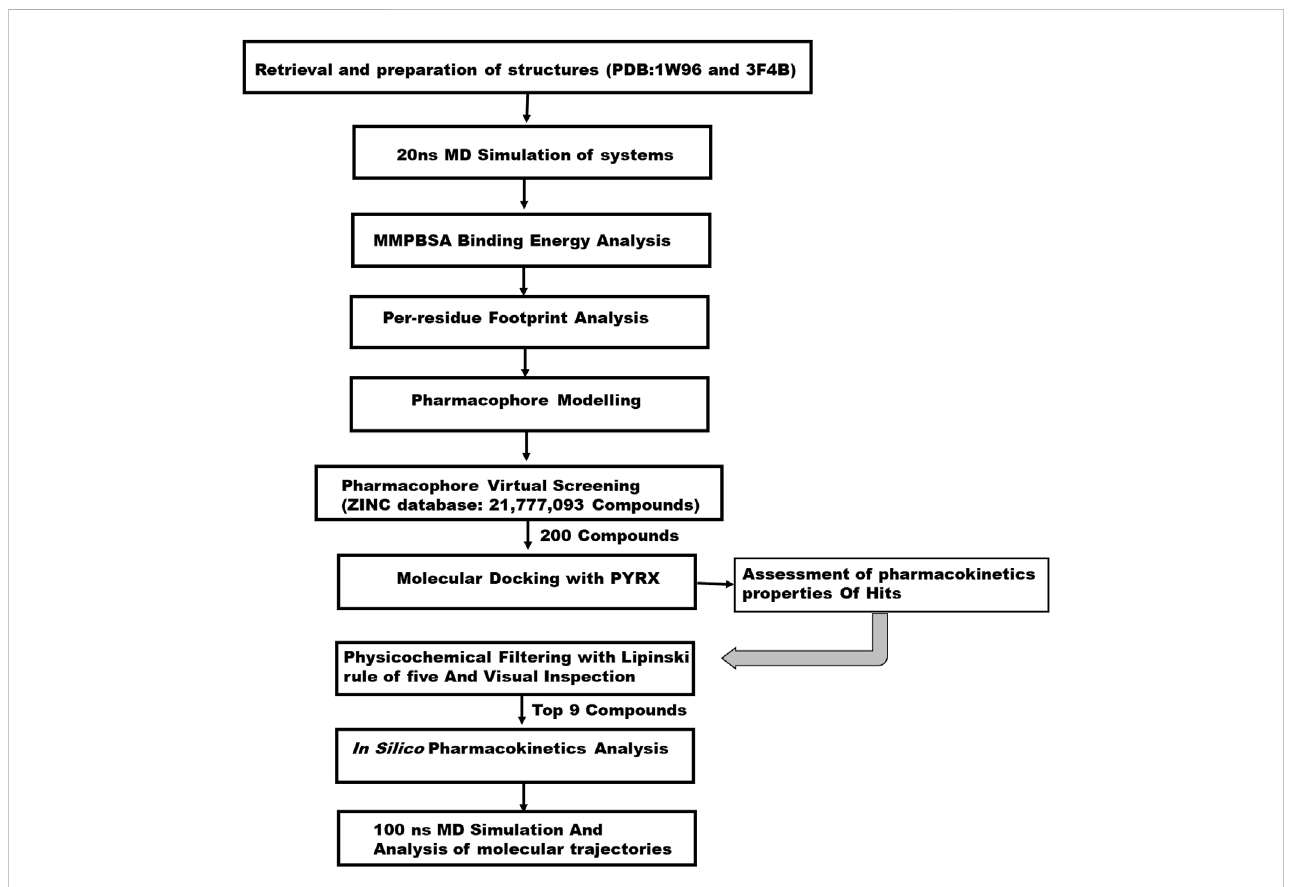
FIGURE 1 A 2D schematic diagram of the work fl